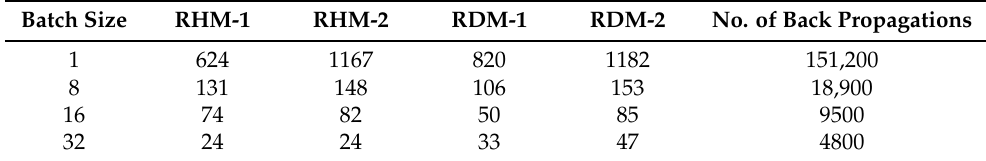
Figure 6. Actual load vs. predicted load. Table 21. Training computation time (s).